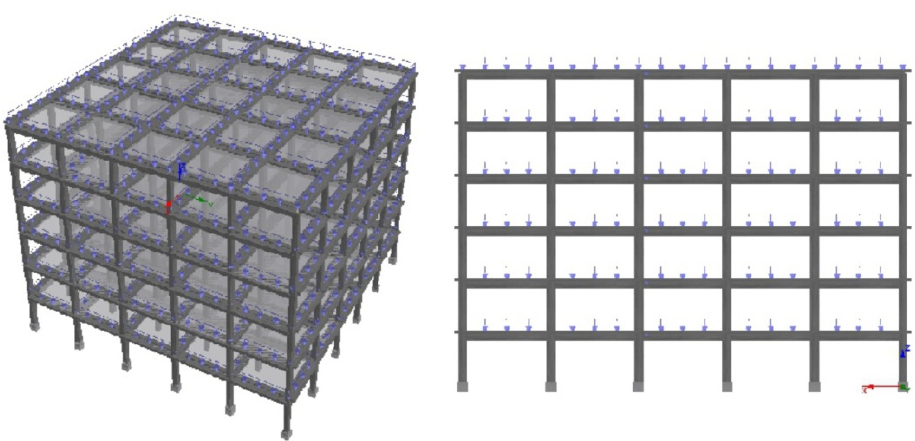
Figure 9. Three- and two-dimensional models of the selected 6-story RC building.